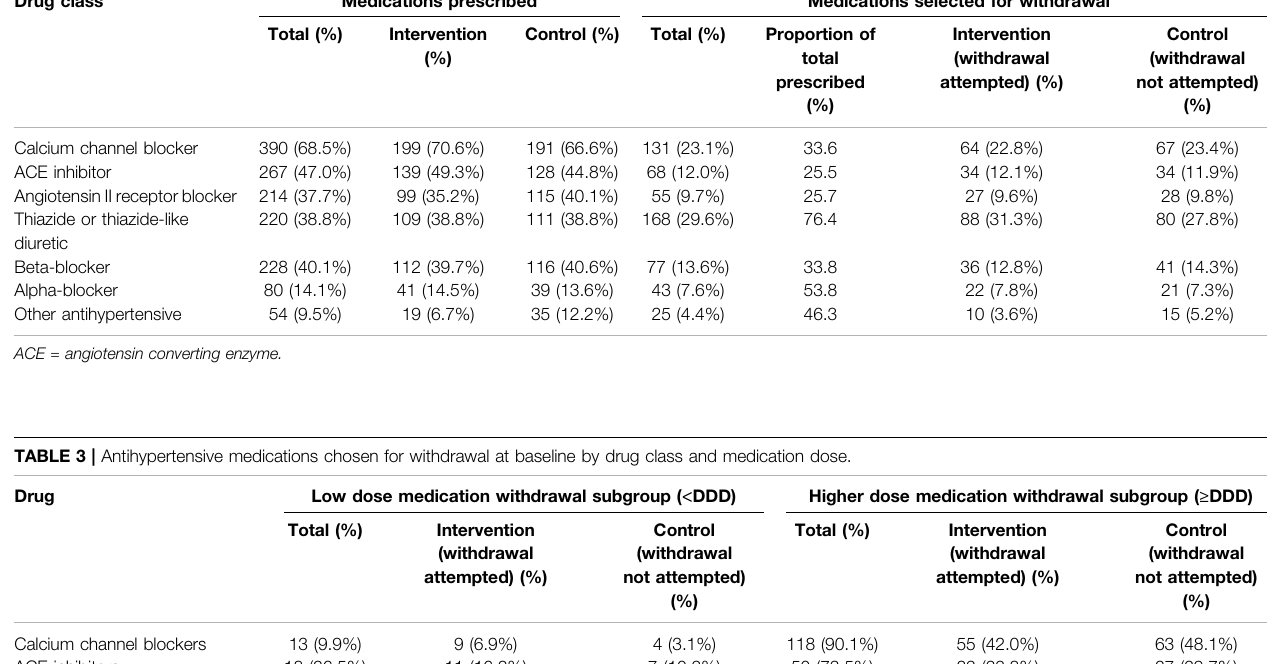
TABLE 2 | Total proportion of medications prescribed and selected for medication reduction by randomized group. Drug class